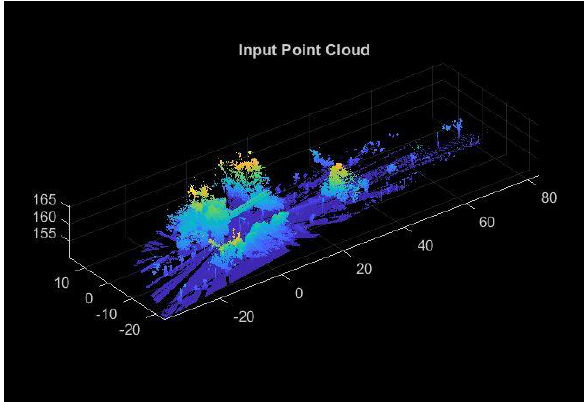
Figure 6. Georeferenced point cloud that is used as an input. extraction of tree segmentation and tree morphological parameters estimation. Sequence of processing steps is given in Figure 7, in which geo-referenced point cloud is taken as input.